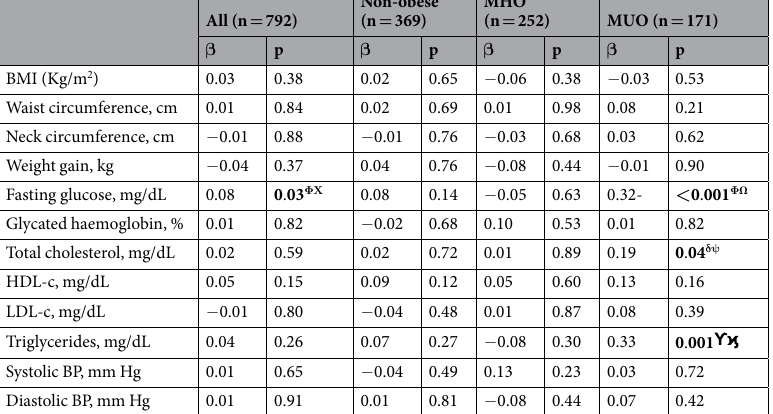
Table 2. Associations between social jetlag and anthropometric, metab olic parameters and blood pressure according to obesity status (n = 792) Φ Multivariate linear regressions analysis adjusted for age, sex, family income, time of diagnosis of type 2 diabetes mellitus, insulin use, minutes of physical activity per week, mean of sleep time. δ Multivariate linear regressions analysis adjusted for age, sex, family income, time of diagnosis of type 2 diabetes mellitus, time of diagnosis of dyslipidaemia, insulin use, use of antidepressants and mean of sleep time. Multivariate linear regressions analysis adjusted for age, sex, family income, employment status, time of diagnosis of dyslipidaemia and use of sleeping pills. Χ r 2 adjusted = 0.11; Ω r 2 adjusted = 0.13; ψ r 2 adjusted = 0.01;